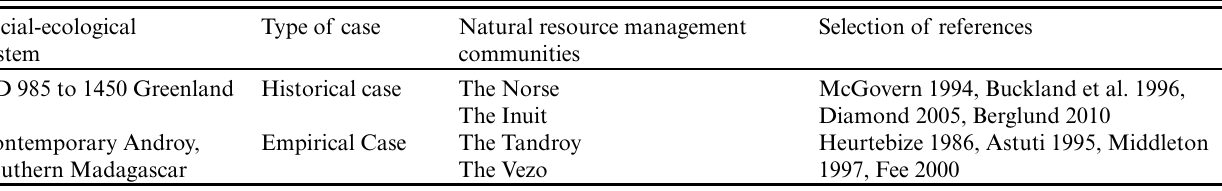
Table 1 . The two social-ecological case studies: Greenland between late AD 900 and mid-1400 and contemporary Androy, Madagascar.